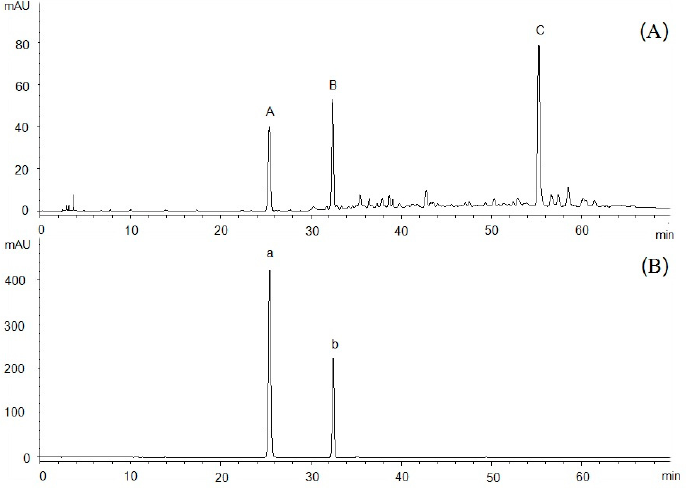
Figure 2. High-performance liquid chromatography (HPLC) chromatograms of fraction Fr.4 and